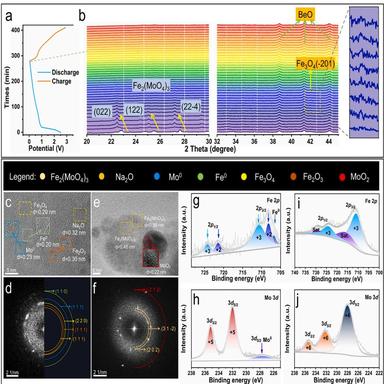
Reaction mechanism of L-FMO assemblies as SIBs anode: (a, b) The in-situ XRD spectra during charge/discharge. Ex-situ HRTEM images and FFT patterns at fully discharged state (0.01 V) (c, d) and at fully charged state (3 V) (e, f), respectively. XPS spectrum of Fe 2p and Mo 3d at different reaction stages, (g, h) discharged to 0.01 V, (i, j) charged to 3 V.